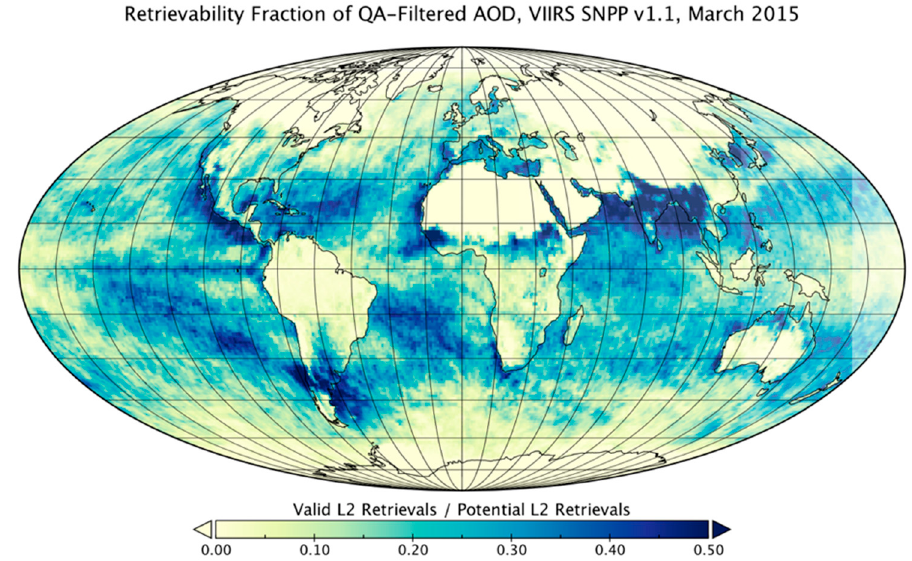
Figure 12. Fraction of retrieval boxes within the VIIRS level 2 swath where 0.55 µ m AOD could be retrieved in March 2015. The global mean retrievability is 0.16.